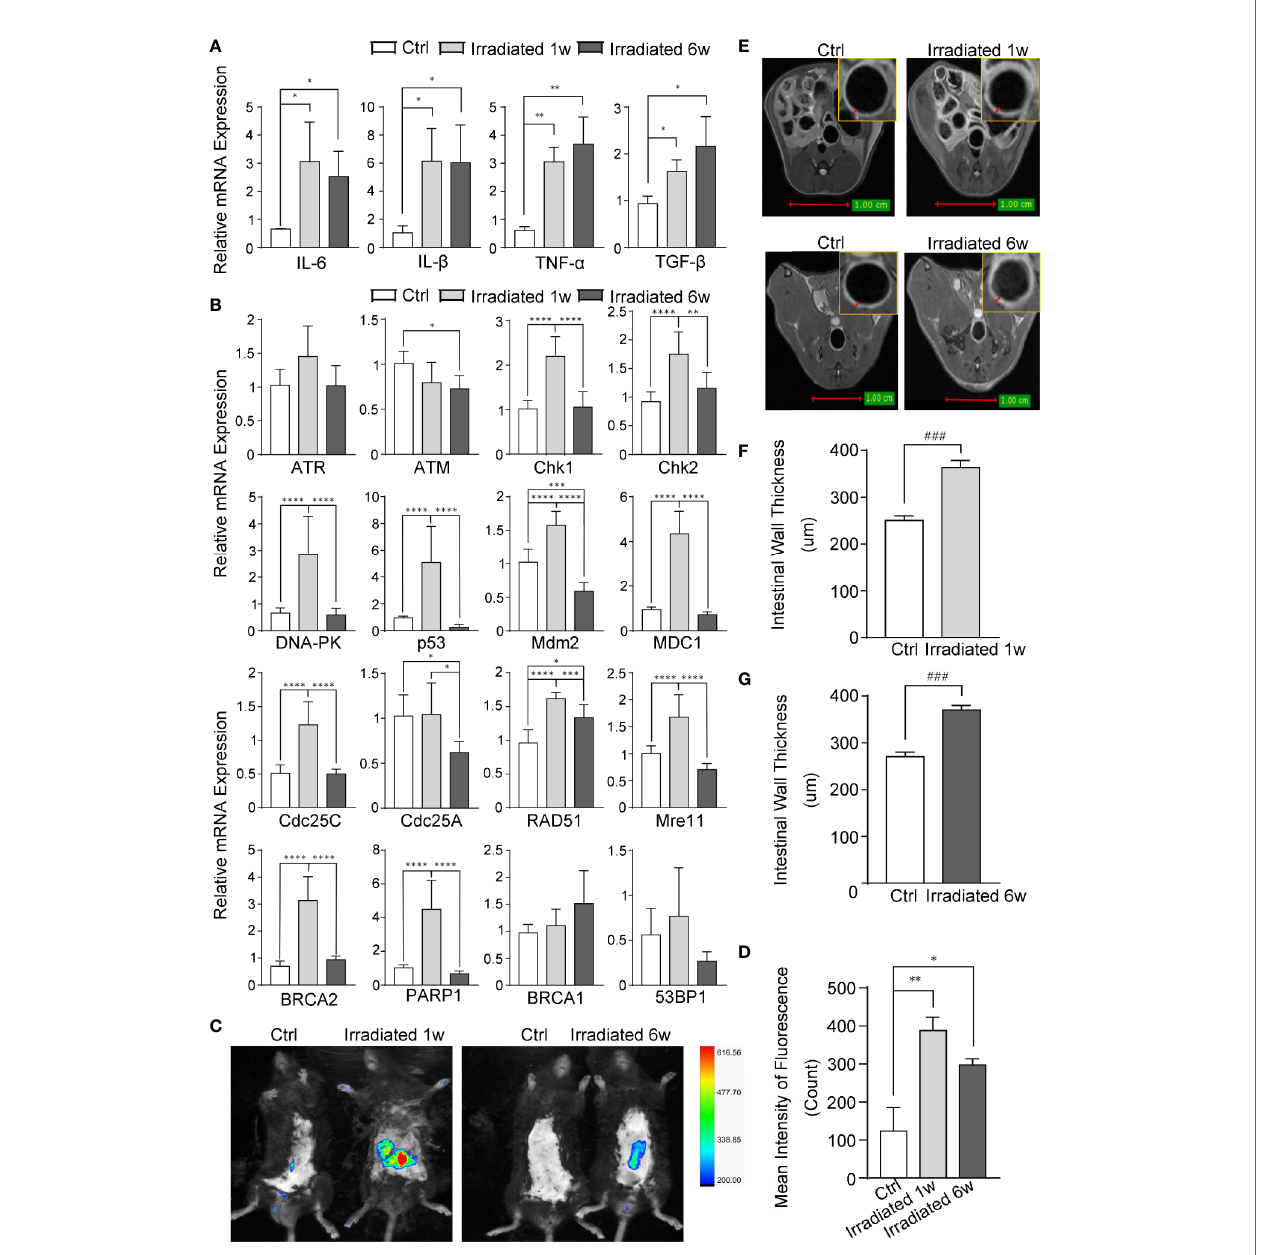
FIGURE 2 | Evaluation of RE by biomarkers and imageological examinations in mice. (A) The expression of classical in fl ammatory cytokines. (B) The expression of genes involved in DNA damage and repair in response to radiation. (C) Detection of ROS by using Luminol-based chemiluminescent probe L-012 and In-Vivo FX PRO in vivo imaging system. (D) Quanti fi cation of the fl uorescence signal intensity of ROS at 1 week and 6 weeks post-irradiation. (E) MRI for radiation-induced regional in fl ammation at 1 week and 6 weeks post-irradiation. (F, G) Intestinal wall thickness in MRI, as indicated by red arrows. Signi fi cance levels are indicated as follows: ****q < 0.0001, ***q < 0.001, **q < 0.01, *q < 0.05; ### p <